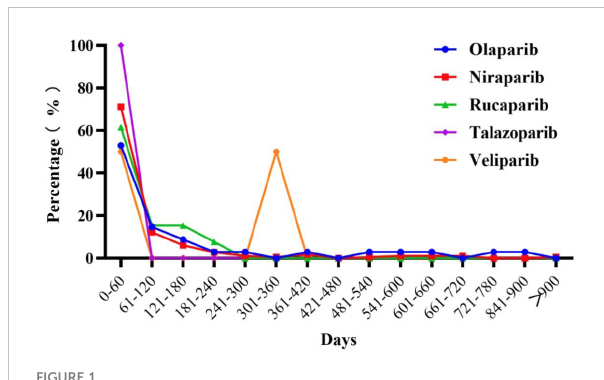
FIGURE 1 The proportion of onset time of PARPis haemorrhages-related adverse